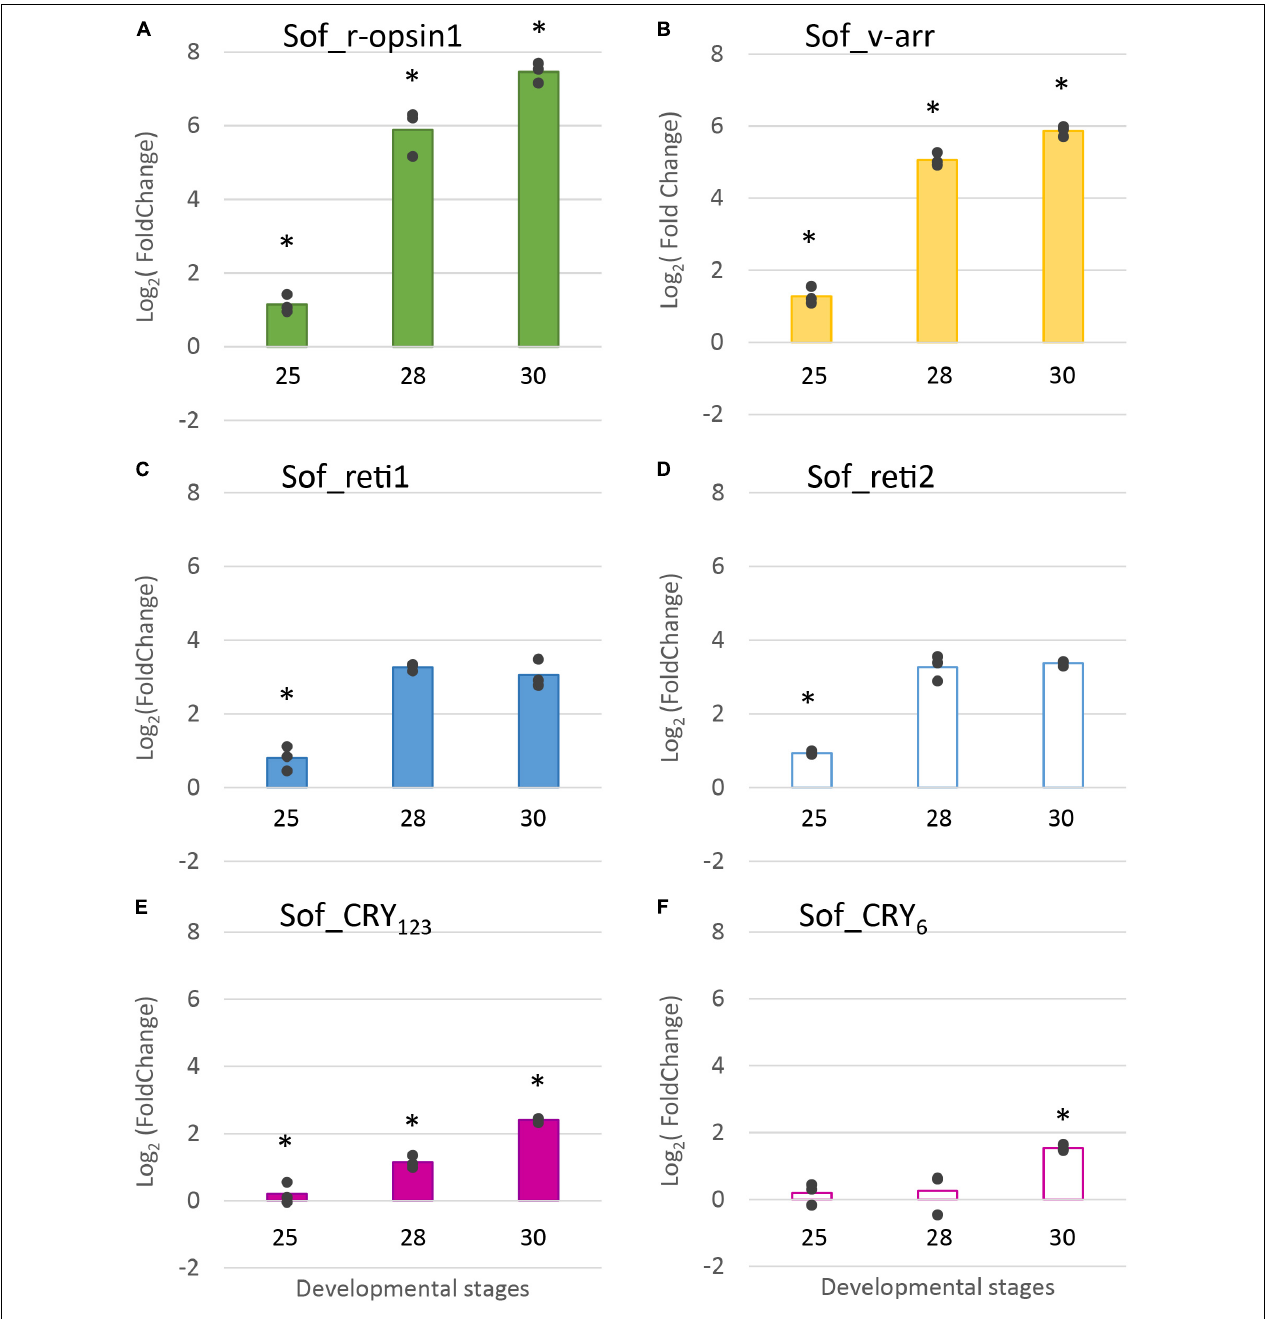
FIGURE 8 | Differential expression of light sensitive molecules at several embryogenic stages. Genes considered are: (A) . R-opsin1, (B) . visual arrestin (C) . retinochrome 1 (D) . retinochrome 2 (E) . CRY 123 and (F) . CRY 6 . The average log 2 Fold Change for the three developmental stages (stage 25, stage 28 and stage 30) is given in comparison to stage 23. In addition, all data points are plotted to show actual variability.* = results significantly different from the other ( p = 0.05).